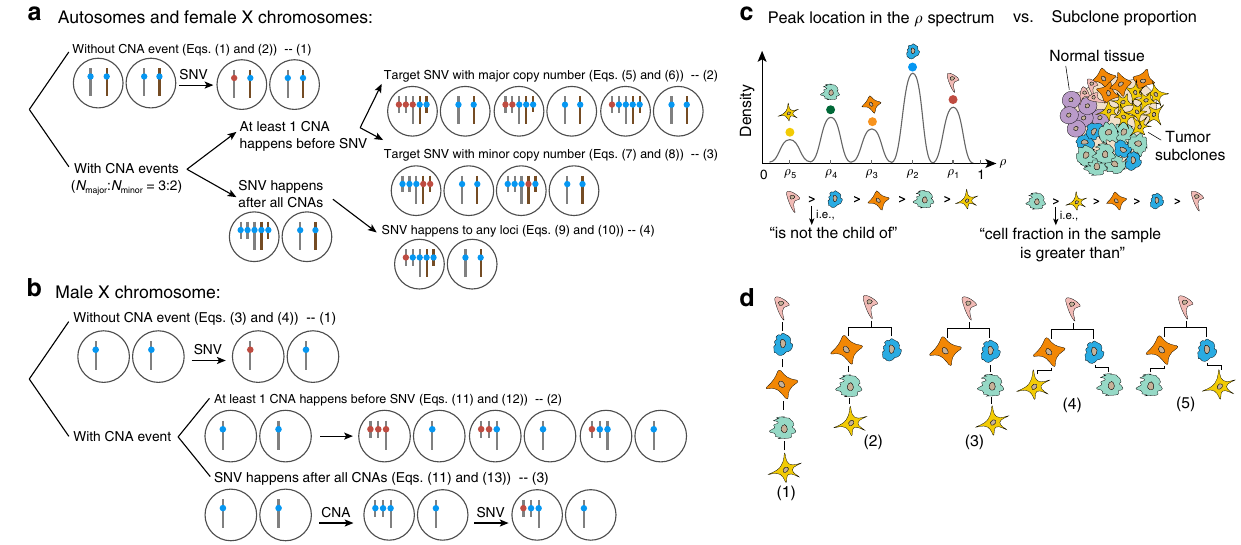
Fig. 2 Calculating the prevalence of cells with target SNV ( ρ ) and predicting phylogenetic trees. a , b Gray bars represent maternal chromosomes and brown bars represent paternal chromosomes, blue spheres represent normal loci, and red spheres represent mutated loci that contain SNVs. c The distribution of peaks ’ location on the ρ spectrum (left panel) will allow the identi fi cation of subclones (right panel). Dots in different colors represent the SNVs that are assigned to the peaks. Intuitively, an SNV being assigned to a peak indicates this SNV occurs in the subclone that is related to this peak. The i th peak ’ s location ρ ρ i indicates that i percent of the cells contain the SNVs assigned to this peak. Since all child subclones contain the SNVs inherited from their parent subclones, the ρ value of child subclones should be smaller than their parent subclones. Therefore, a subclone with a smaller peak location in the ρ spectrum cannot be the parent of a subclone associated with a peak of larger ρ . However, each subclone ’ s fraction in the sample is not strictly related to the subclone ’ s position in the phylogenetic tree. d Some examples of possible phylogenetic trees. Based on the hierarchy determined in c , several tree structures may be possible since all of them satisfy the above